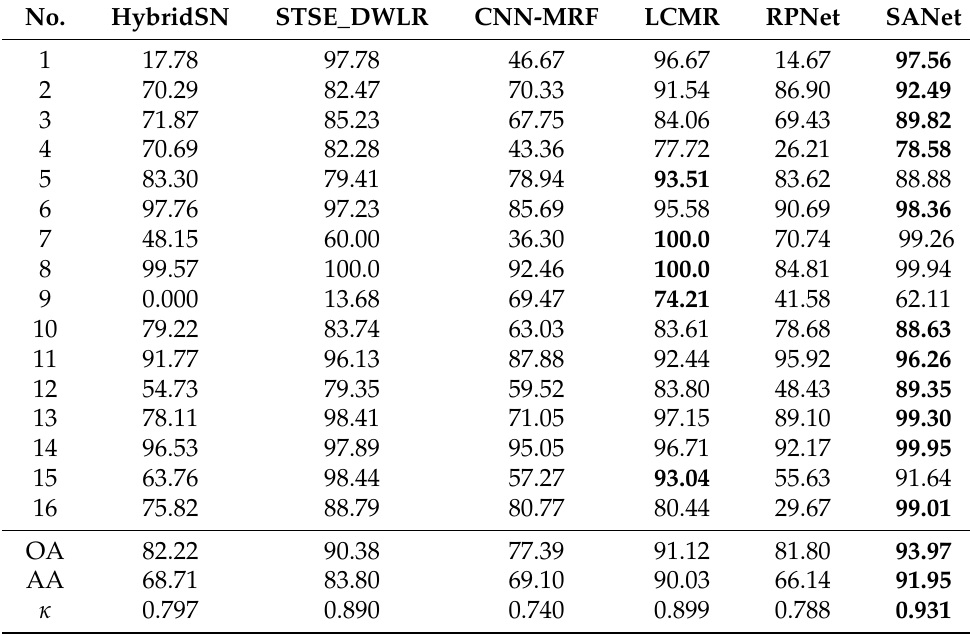
Table 1. Classification accuracies of HybridSN, STSE_DWLR, CNN-MRF, LCMR, RPNet, and SANet on the Indian Pines data set. The best results are highlighted in bold